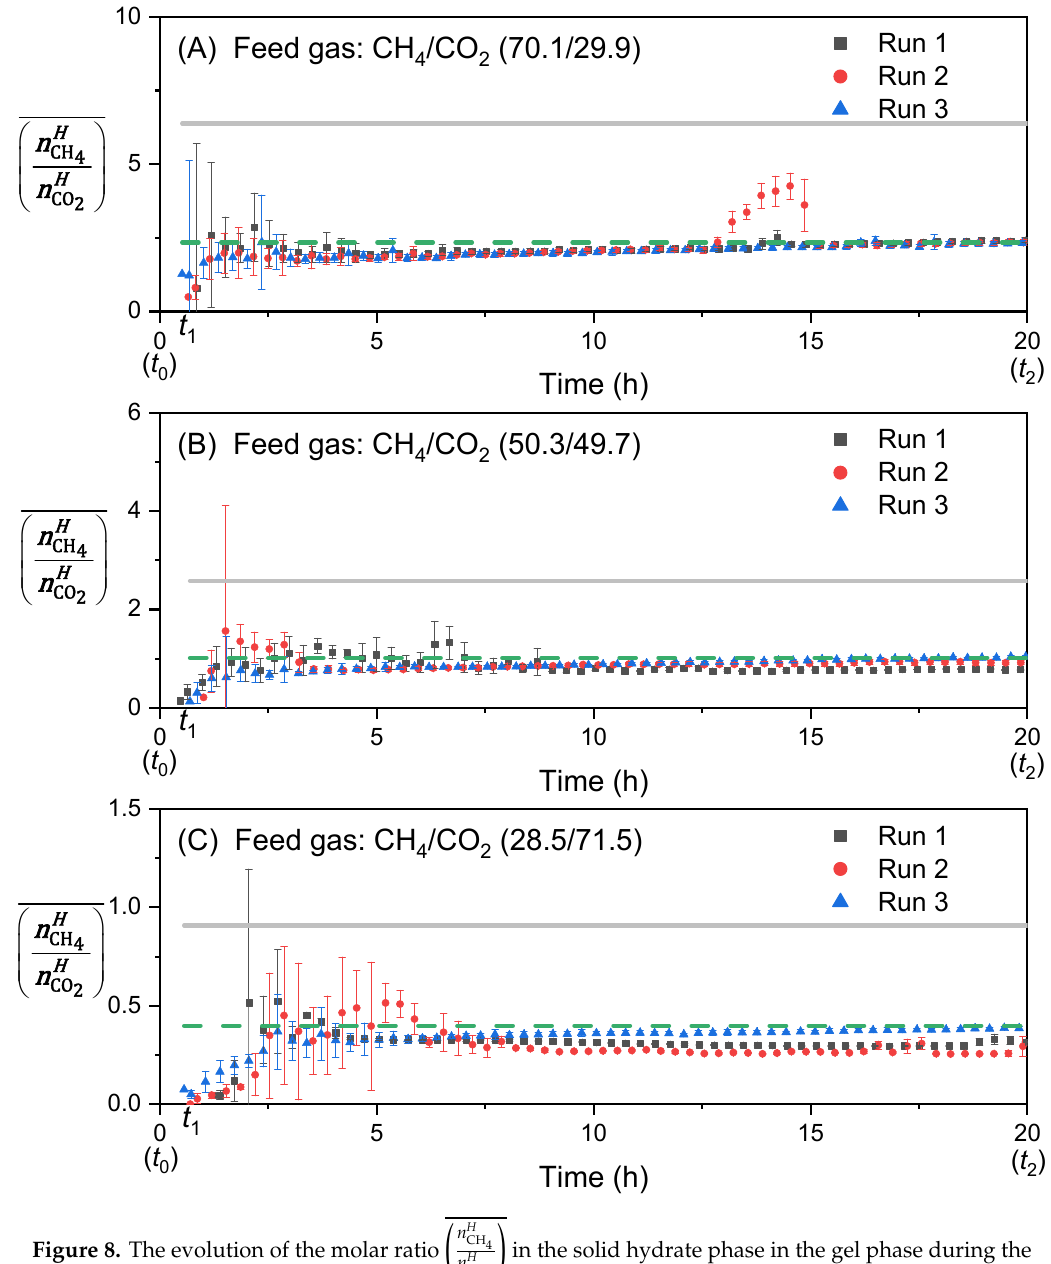
(cid:32) (cid:33) (cid:3440)(cid:3364)(cid:3364)(cid:3364)(cid:3364)(cid:3364)(cid:3364)(cid:3364)(cid:3364) n H (cid:3041) (cid:3135)(cid:3140)(cid:3120)(cid:3257) CH4 Figure 8. The evolution of the molar ratio in the solid hydrate phase in the gel phase during the Figure 8. The evolution of the molar ratio (cid:3436) in the solid hydrate phase in the gel phase during n H (cid:3041) (cid:3135)(cid:3147)(cid:3118)(cid:3257) CO2 hydrate formation at p ini = 4 MPa and for three di ff erent initial gas compositions. The dashed lines the hydrate formation at 𝑝 (cid:3036)(cid:3041)(cid:3036) (cid:3404) 4 𝑀𝑃𝑎 and for three different initial gas compositions. The dashed indicate the initial CH 4 / CO 2 ratio at t 0 of the feed gas, and the solid grey lines indicate the CH 4 / CO 2 lines indicate the initial CH 4 /CO 2 ratio at 𝑡 (cid:2868) of the feed gas, and the solid grey lines indicate the ratio in the vapor phase at the end of the hydrate formation at t 2 . ( A ) feed gas methane fraction 0.701, CH 4/ CO 2 ratio in the vapor phase at the end of the hydrate formation at 𝑡 (cid:2870) . A) feed gas methane ( B ) feed gas methane fraction 0.503 and ( C ) feed gas methane fraction 0.285. fraction 0.701, B) feed gas methane fraction 0.503 and C) feed gas methane fraction 0.285. starts with